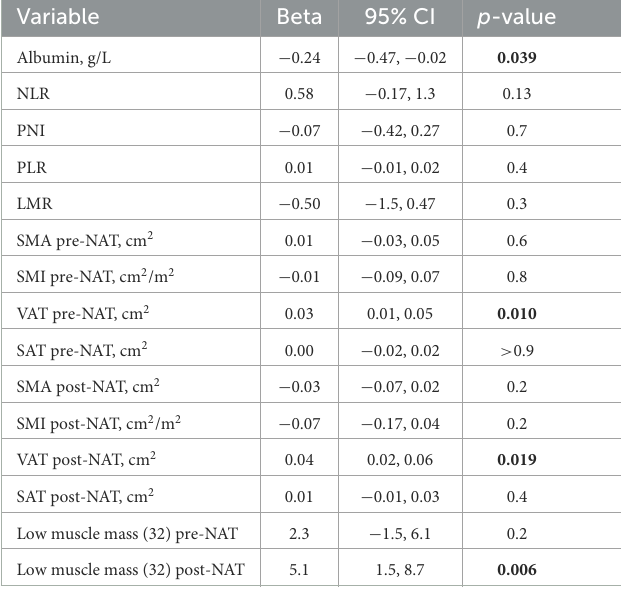
TABLE 4 Univariable analysis and length of stay (extracted from Supplementary Table